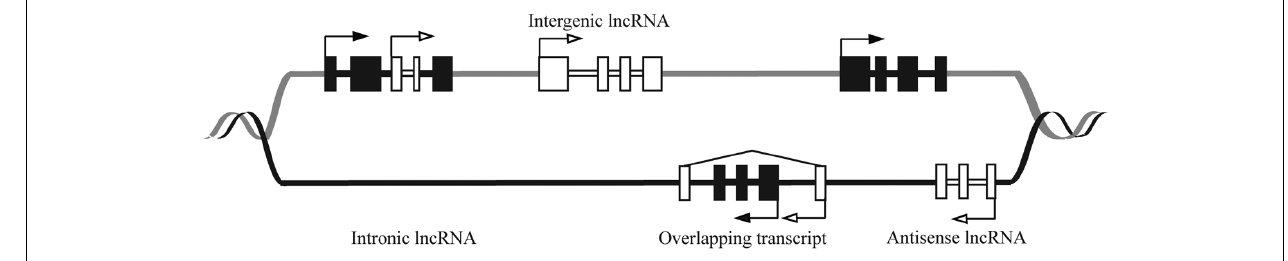
shows that lncRNAs can be antisense to protein coding (antisense lncRNA) or originate from introns of protein coding genes either as by-products of mRNA or as independent transcripts (intronic lncRNA, sense lncRNA). LncRNA also can be transcribed from intergenic regions of the genome (lincRNA). LncRNA genes can overlap the protein-coding genes (overlapping transcript).